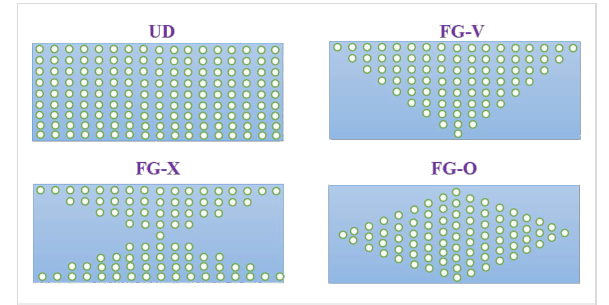
Figure 2: Various graded patterns of FG-CNTRC plates.